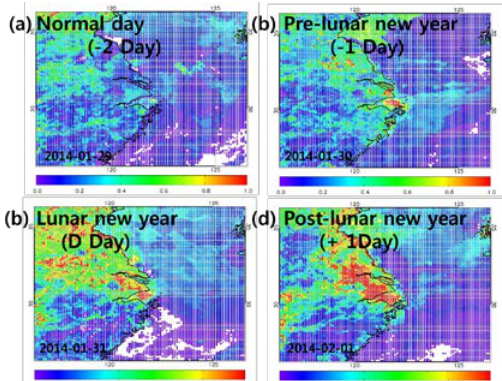
Figure. 2. 14-year Average MODIS-AOD for (a) normal day, (b) pre-lunar new year, (c) lunar new year, and (d) post-lunar new year